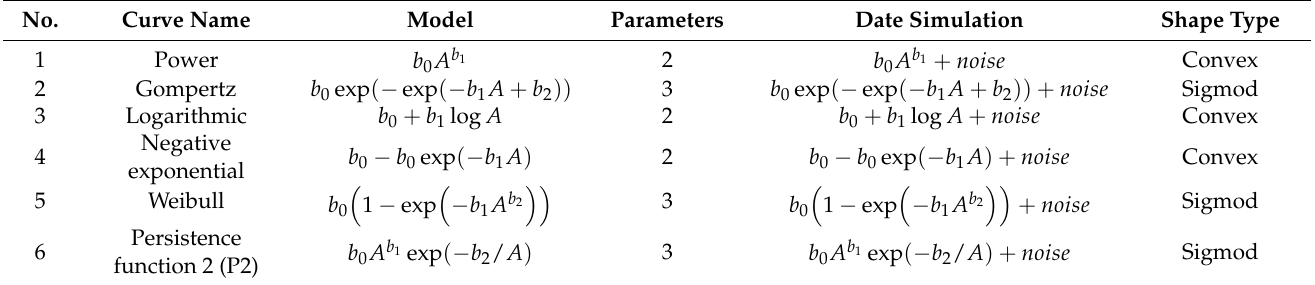
Table 1. SAR models used to evaluate the applicability of the different algorithms, and the function with white noise. In this case, the independent variable ( A ) is area and the dependent variable f ( x ) is the number of species, b 0 , b 1 and b 2 are the parameters.